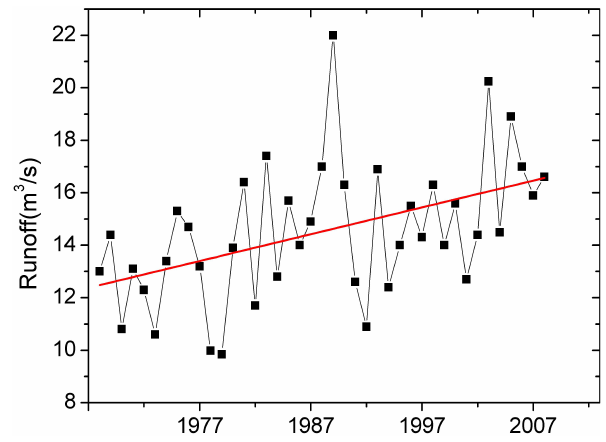
Fig. 8. Average annual runoffs of QiLian